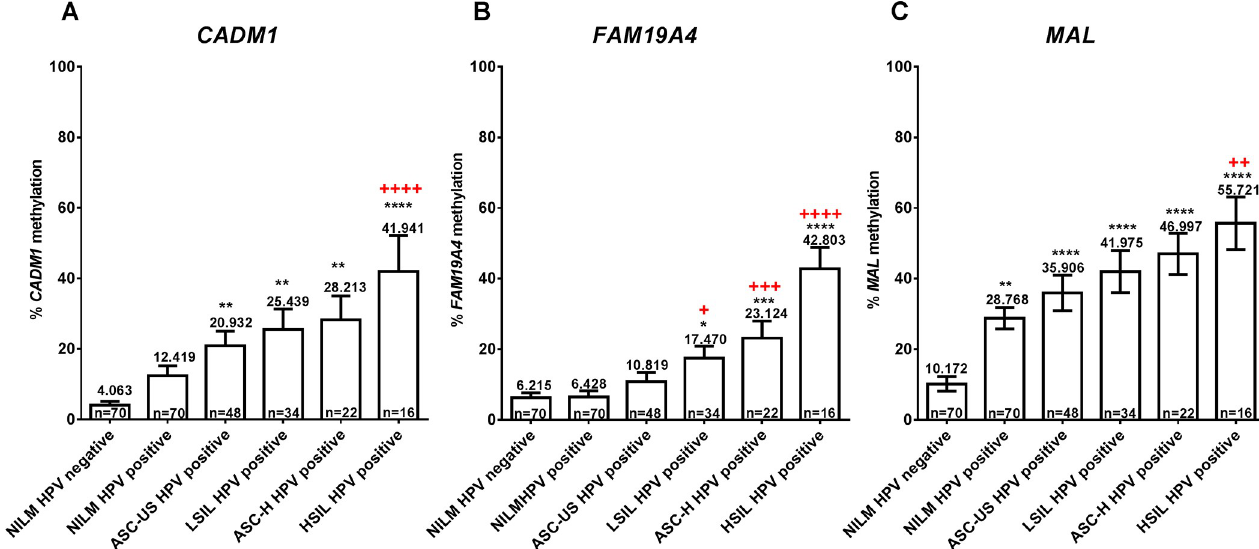
Fig 2. The methylation levels of three candidate genes; CADM1 (A), FAM19A4 (B), and MAL (C), in the different cytologic grades (ANOVA with turkey’s multiple comparison post hoc test � p < 0.05, �� p < 0.01, ��� p < 0.001, ���� p < 0.0001 vs. NILM&HPV-negative group, and + p < 0.05, ++ p < 0.01, ++ + p < 0.001, ++++ p < 0.0001 vs. NILM&HPV-positive group).